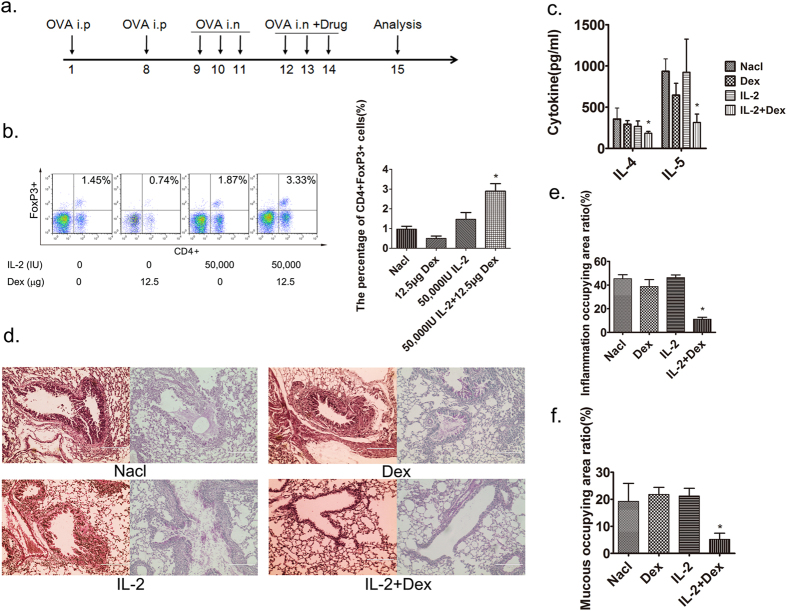
Manifestations of allergic airway disease after intratracheal use of IL-2 plus dexamethasone.Intratracheal administration of IL-2 and Dexamethasone upregulated Tregs in BALF and alleviated asthma. (a) Timeline of drug intervention and analysis. Female BALB/c mice were immunized with OVA i.p on days 1 and 8, followed by intranasal (i.n) 2% OVA challenges on days 9–14. And 50,000 IU IL-2 plus 12.5 μg dexamethasone (Dex) were administrated intratracheally on days 12–14. On day 15, mice were sacrificed and analyzed by flow cytometry and histopathology. (b) Detection of CD4+FoxP3+ Treg cell composition among lymphocytes in BALF by flow cytometry. (c) Analysis of Th2 cytokines IL-4 and IL-5 in BALF. (d) H&E and PAS staining of the lung section (scale bars, 200 μm). (e,f) Computer-based quantification of lung inflammation and mucus production. *p < 0.05, 50,000 IU IL-2 plus 12.5 μg dexamethasone group versus other groups by two-way ANOVA analysis. Data are presented as means ± SEM (n ≥ 8 per group and data point) from 2 independent experiments. i.n., Intranasal; i.p., intraperitoneal. Nacl group, asthma model mice treated with normal saline.